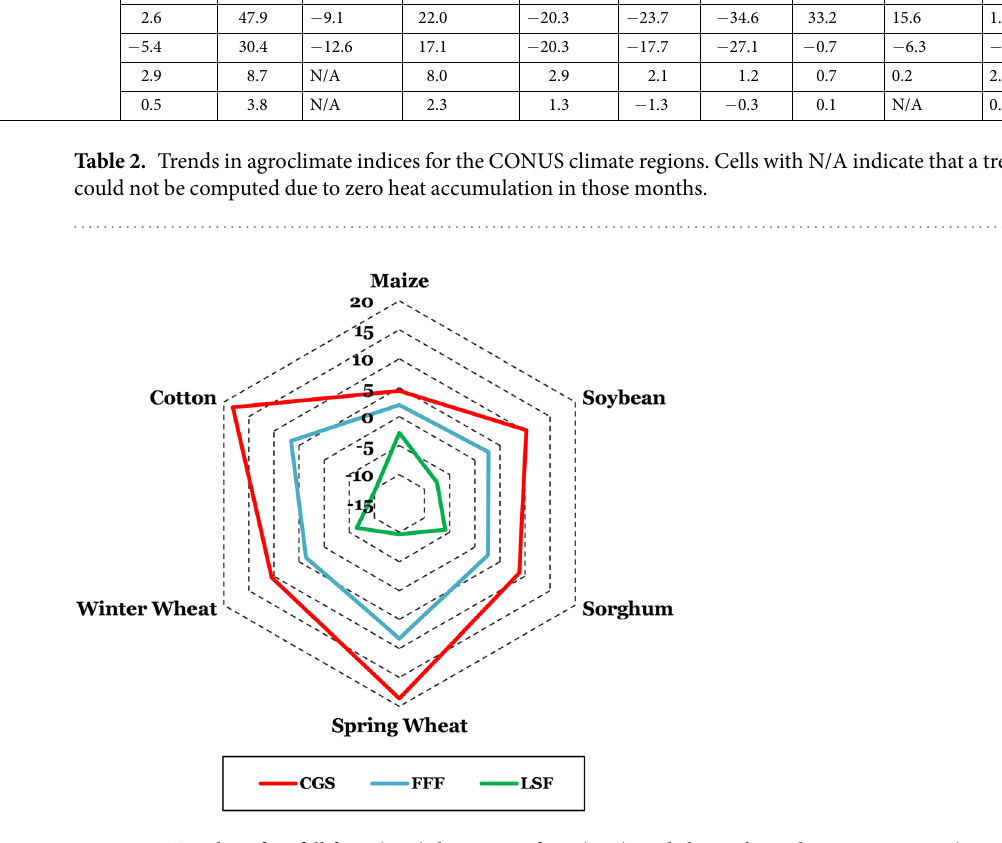
Figure 7. Trends in first fall frost (FFF), last spring frost (LSF), and climatological growing season (CGS) during 1900–2014 representative of each U.S. agricultural